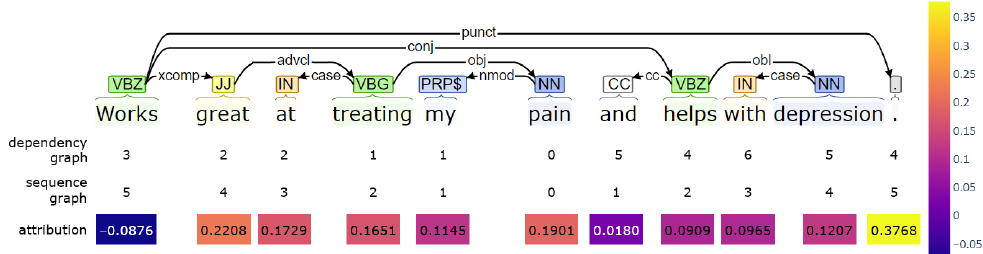
Figure 2. An example of cross-referencing a token’s distance from the aspect in the dependency and sequence graphs, respectively, to its attribution